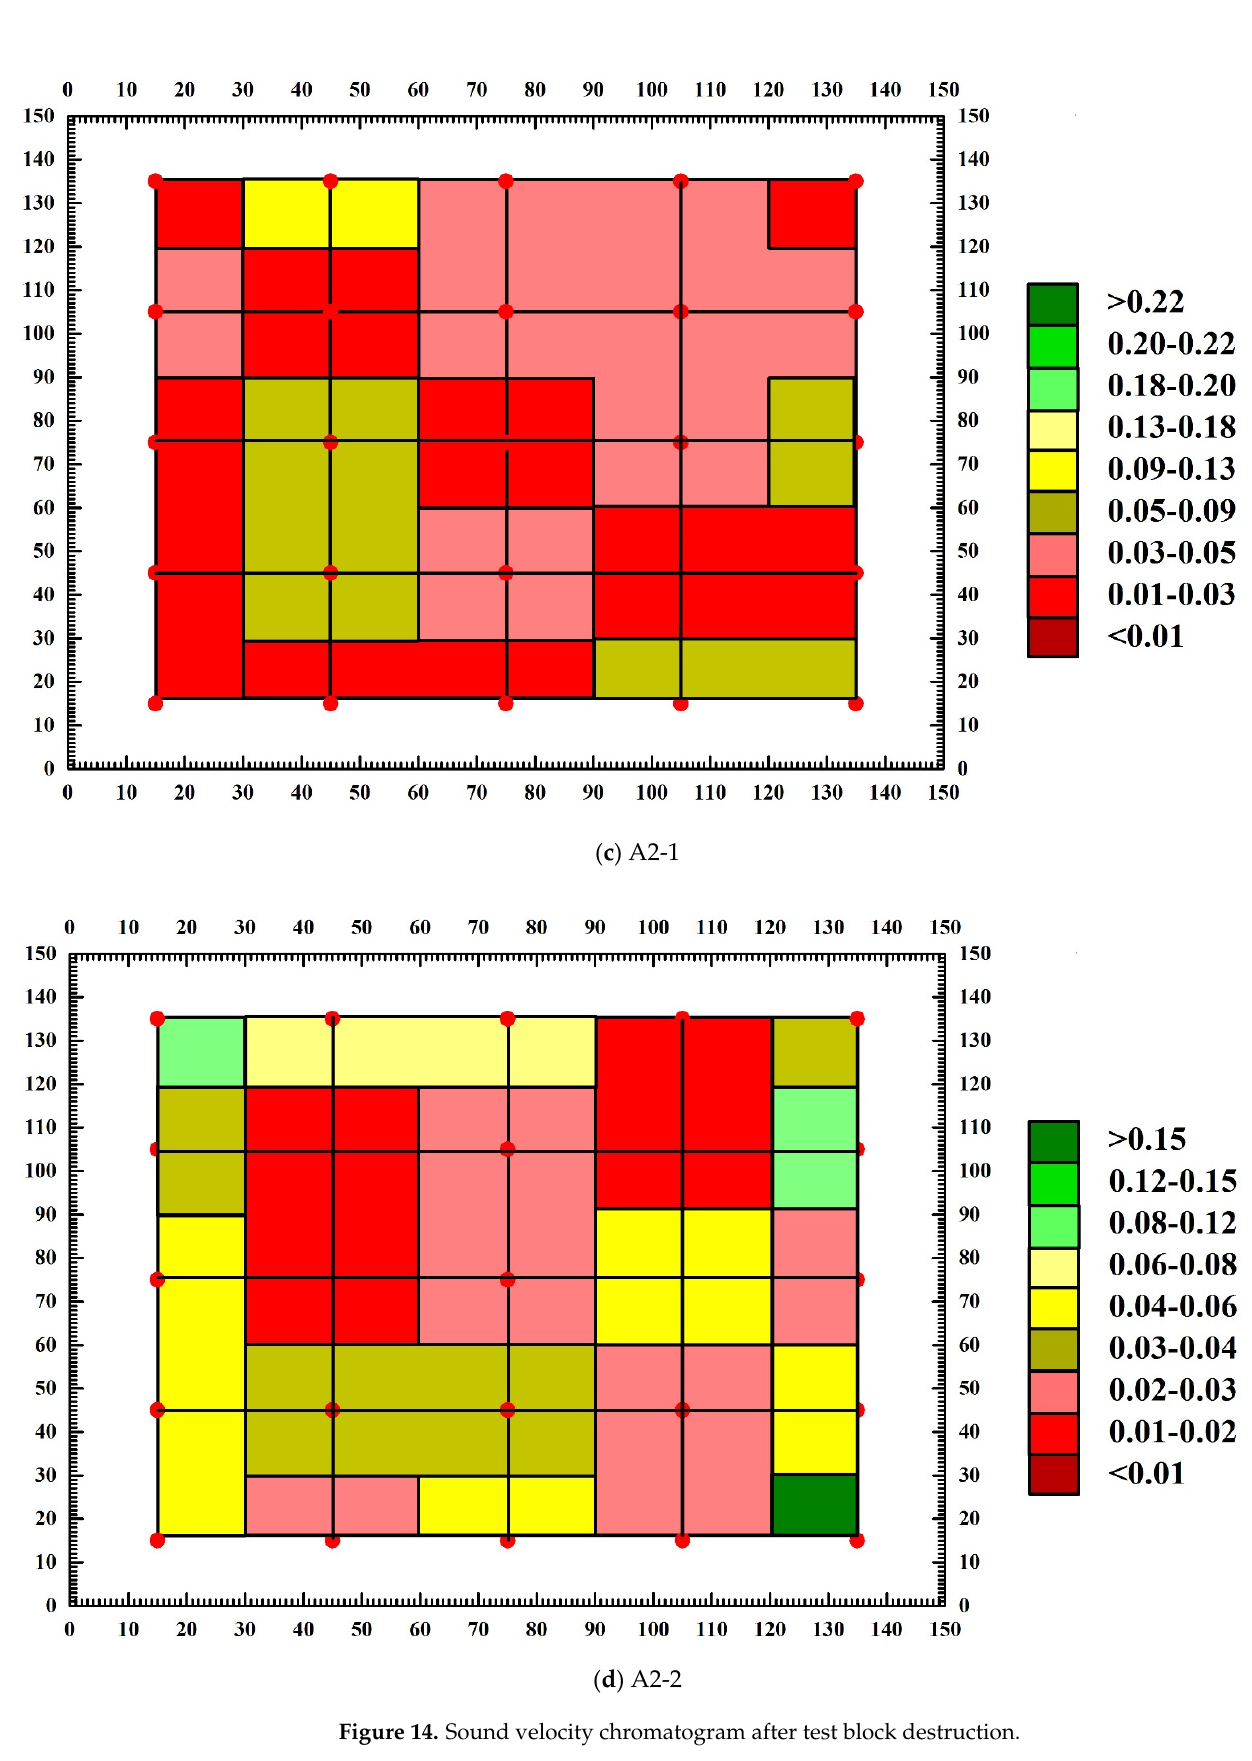
Figure 14. Sound velocity chromatogram after test block destruction.